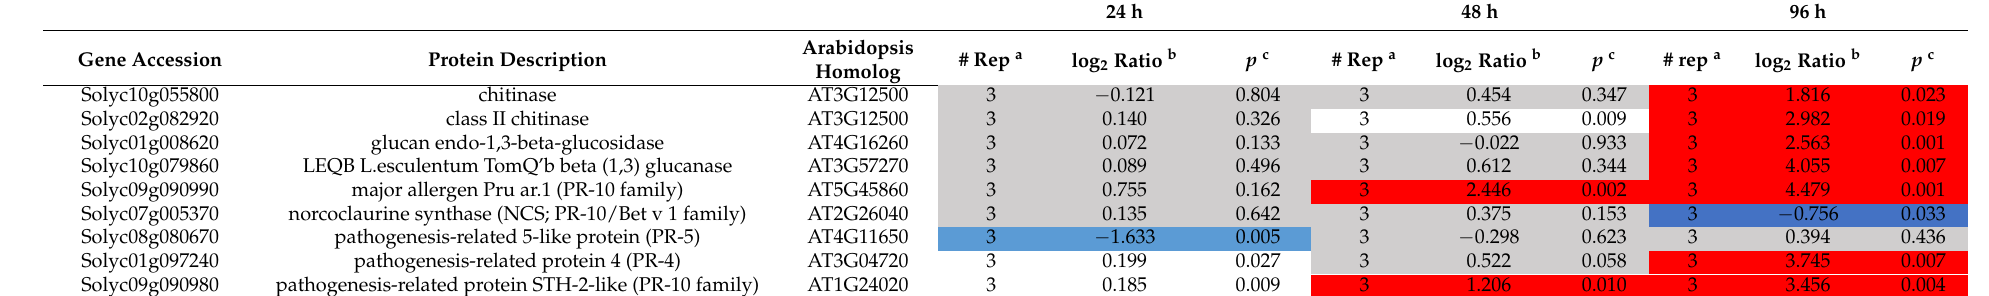
Table 1. Proteins involved in defense mechanisms with a significant change in abundance at 24, 48 and 96 h post-inoculation with P. infestans.